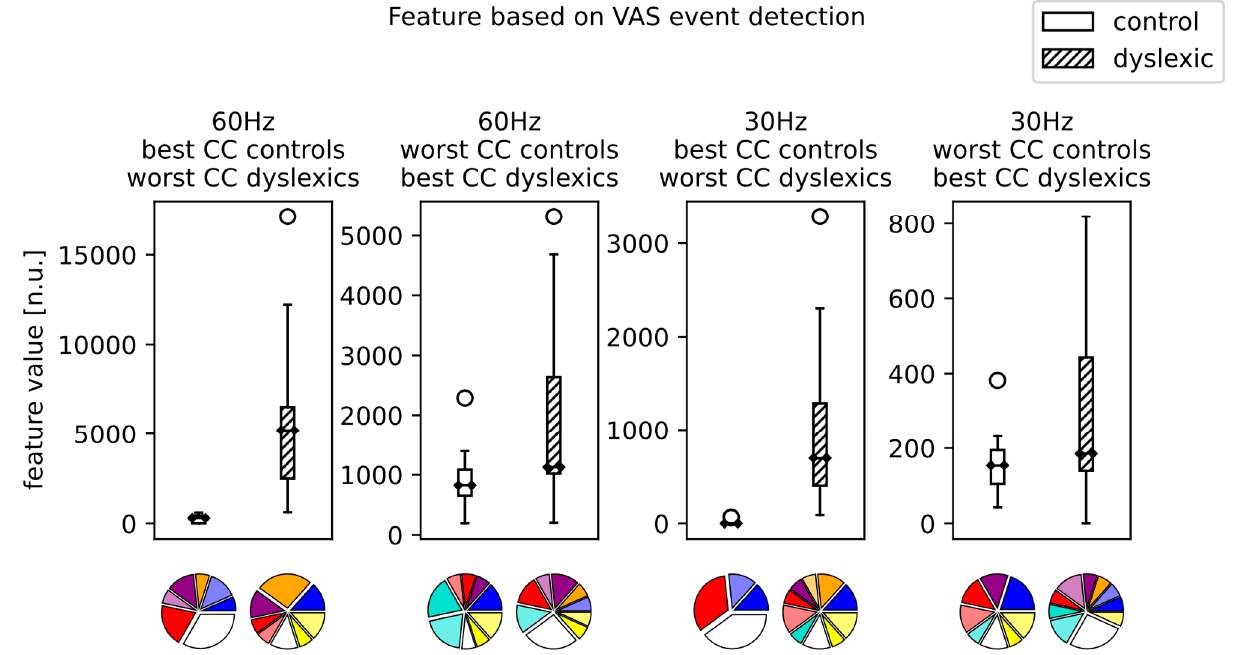
Figure 4. The boxplots showing VAS event feature values for the maximally separated classes (con- trol subjects evaluated on their best CC and the dyslexic subject evaluated on their worst CC) and the classes brought together (dyslexic subjects evaluated on their best CC and the control subject evaluated on their worst CC). Below each boxplot is a pie chart displaying the distribution of CCs that were used for the subjects’ feature values (best- or worst-performing